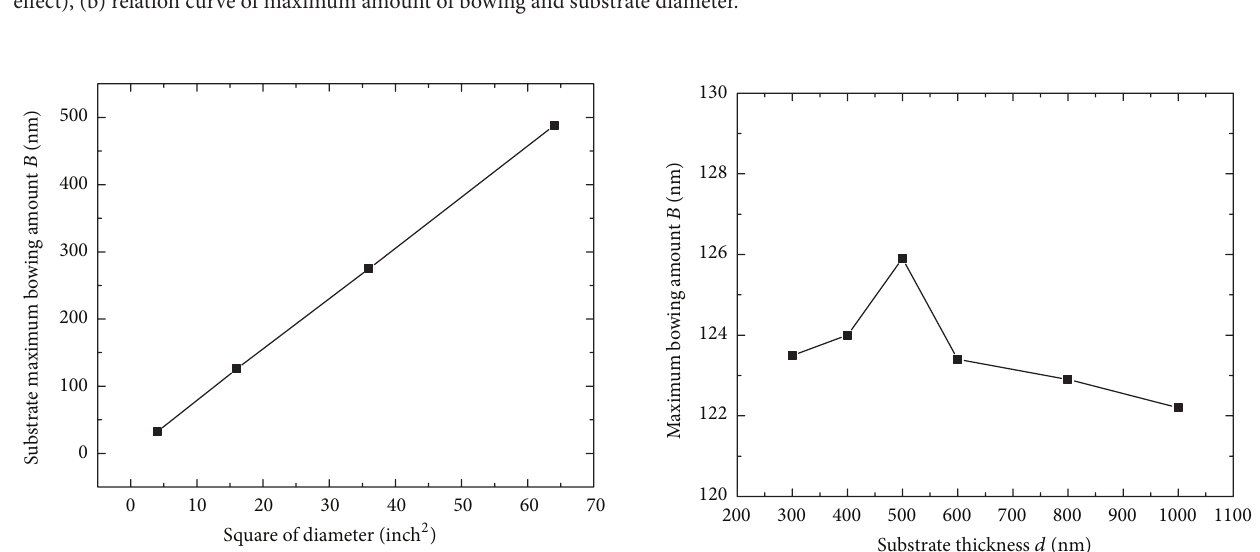
Figure 4: Simulation results of bowing amount of different size substrate (a) deformation of sapphire substrate with different sizes (10 times effect), (b) relation curve of maximum amount of bowing and substrate diameter.